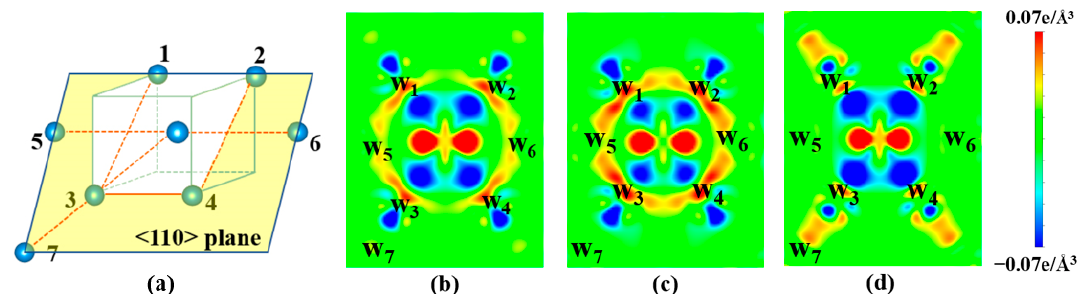
Figure 8. ( a ) The close-packed < 110 > plane across the monovacancy. The differential charge density distributions (in e/Å 3 ) of the < 110 > plane under ( b ) zero strain, ( c ) 5% hydrostatic compressive strain, and ( d ) 5% hydrostatic tensile strain. Materials 2020 , 13 , x FOR PEER REVIEW